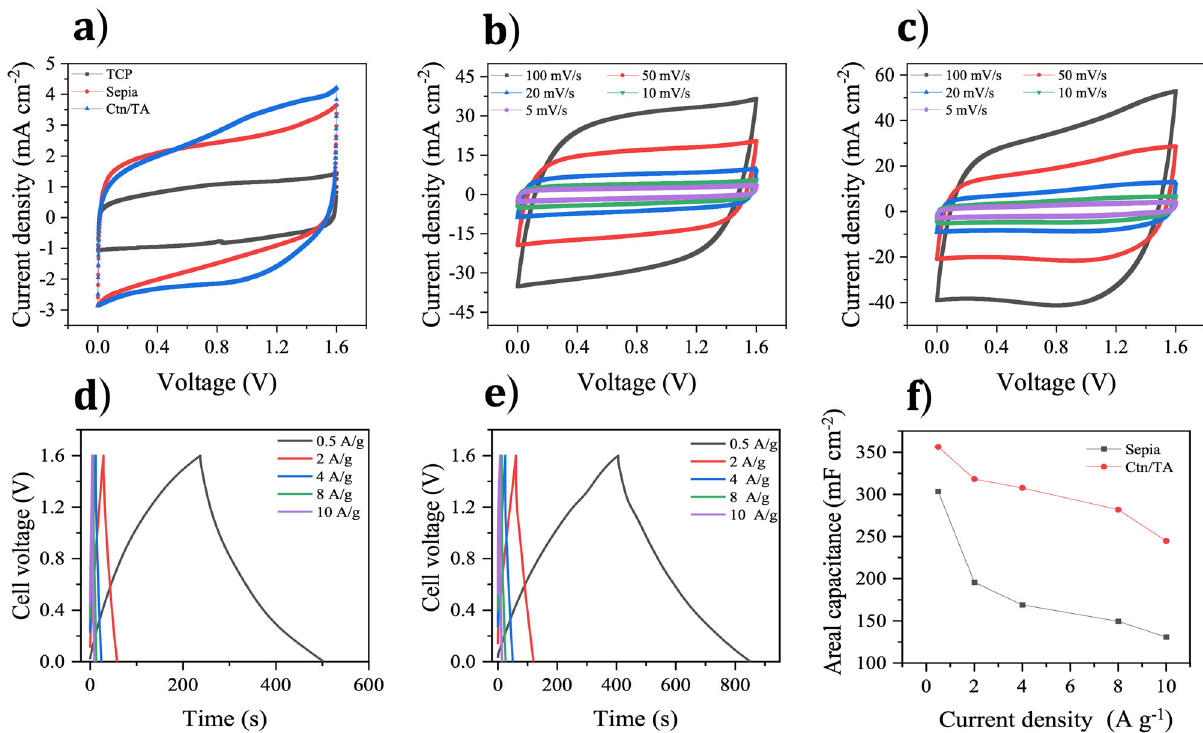
Fig. 5 Electrochemical characterization of symmetric supercapacitors based on TCP, sepia on TCP, and Ctn/TA on TCP in 0.5 M Na 2 SO 4 . ( a ) Cyclic voltammetry at 5 mV s − 1 . ( b ) Cyclic voltammetry of sepia on TCP at different scan rates. ( c ) Cyclic voltammetry of Ctn/TA on TCP at different scan rates. Galvanostatic charge/discharge curves at different current densities of ( d ) sepia on TCP and ( e ) Ctn/TA on TCP. ( f ) Relationship between areal capacitance evaluated from galvanostatic charge/discharge and corresponding current